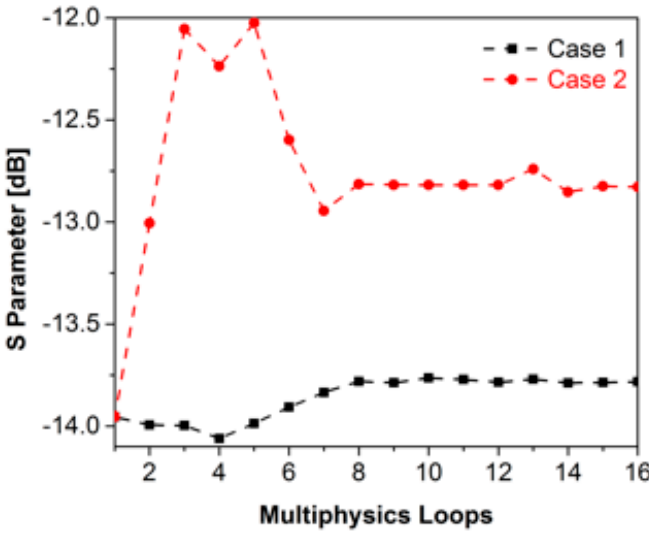
Figure 6. DDM iteration step change and maximum temperature change during multiphysics simulation of case 2.